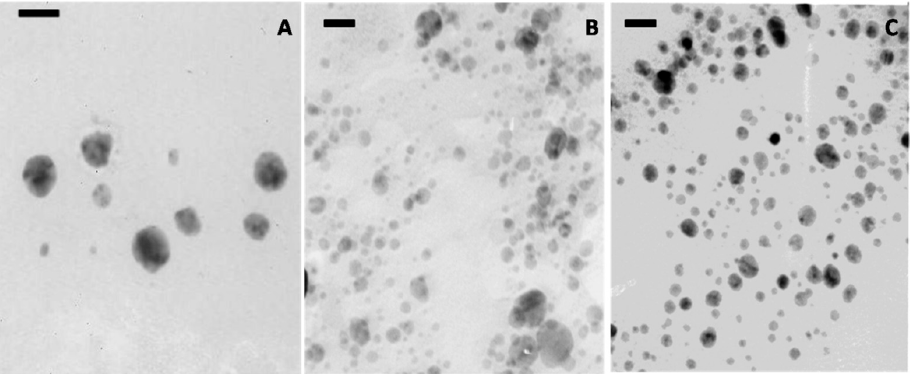
Figure 3. Transmission electron microscopy (TEM) micrographs of AgNPs ‐ CS produced by thermal treatment at 80 °C ( A ), UV irradiation of fresh sample ( B ), and sample rested for 24 h ( C ). Bars are 50 nm in panel A and 20 nm in panels B and C. CS: chondroitin sulfate.